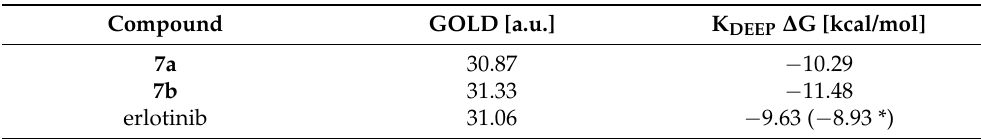
Table 9. The top-ranked ChemScore fitness score function obtained with GOLD and binding energy obtained with K DEEP for betulin derivatives 7a and 7b